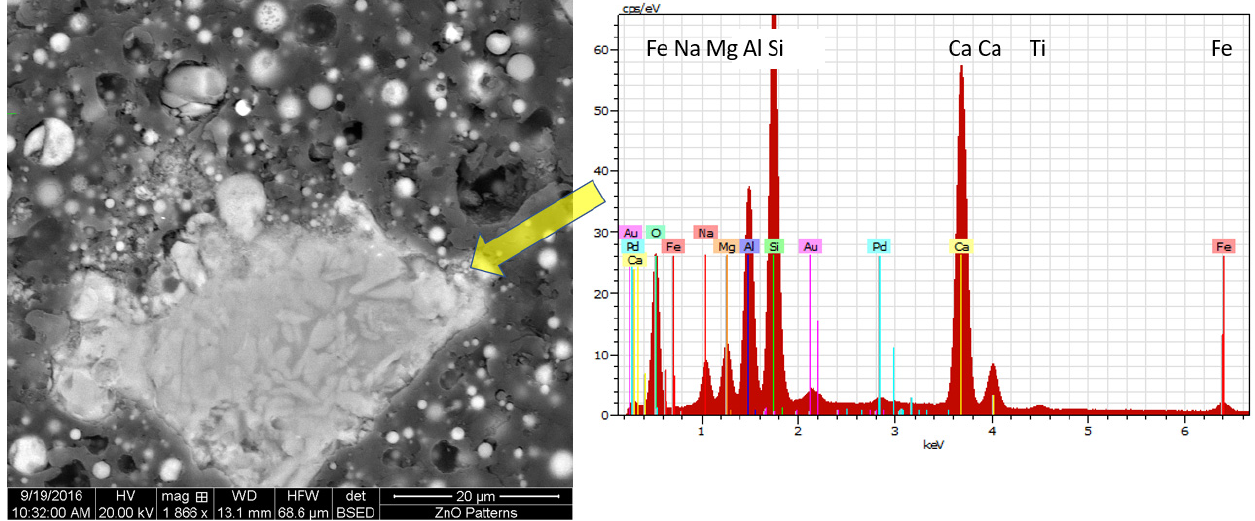
Figure 1. Plagioclase feldspar (bytownite or anorthite), possibly with other minerals, in sample 93927 (PRB-coal-derived fly ash). Left/Back-scatter image of fly ash. Scale = 20 µ m. Right/EDS spectrum of elemental composition of large particle. Signals for Au and Pd are extraneous to the sample. Modified after Hood et al. [15].